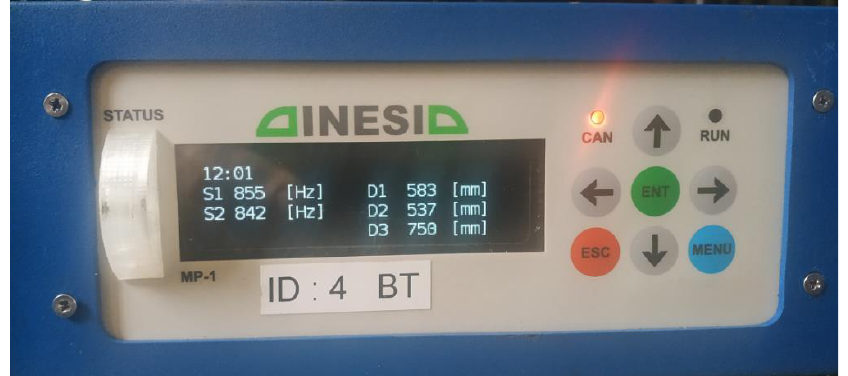
Figure 12. View of the measuring module during